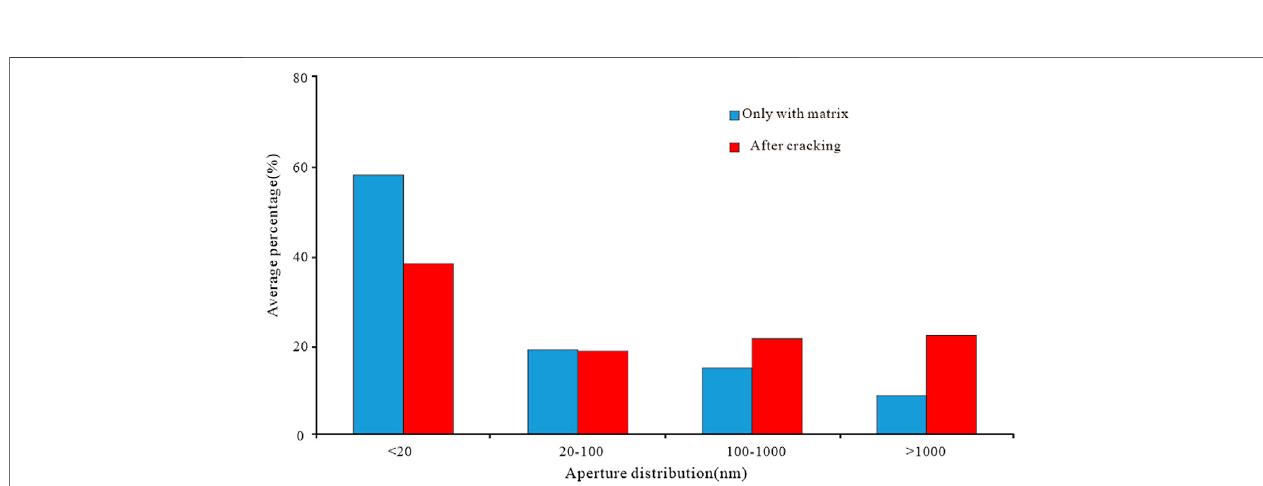
FIGURE 8 | Histogram of the average percentage of pore diameter distribution before and after cracking.